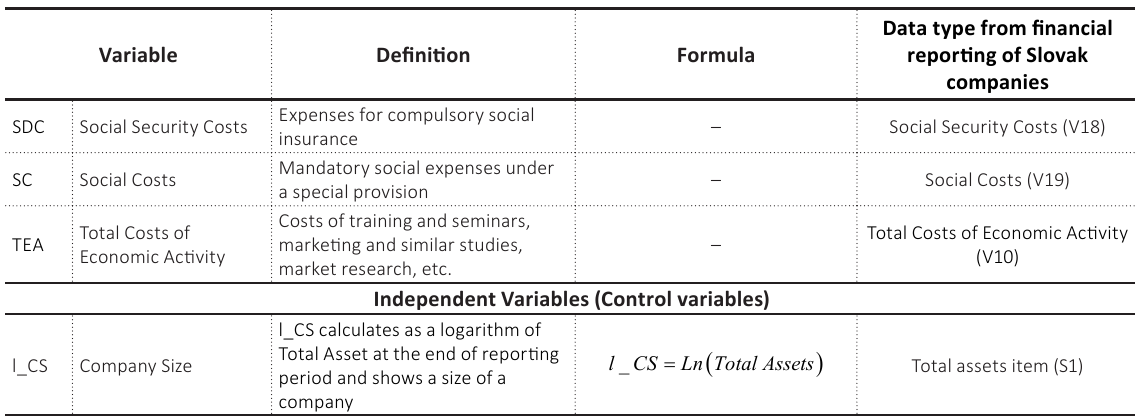
Table B1 (cont.). Characteristics of dependent and independent variables for analysis of the relation between profitability and intellectual